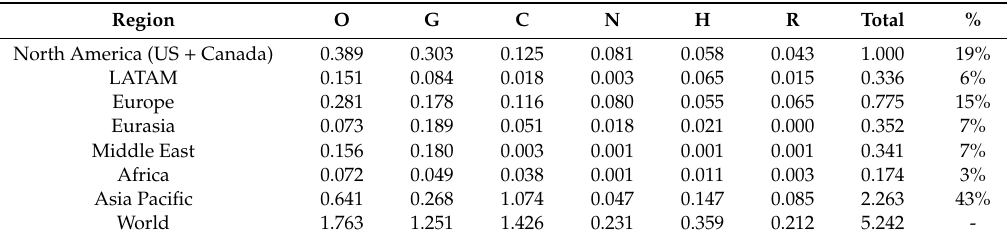
Table 1. World’s relative primary energy consumption by region in 2018. All columns, except the last, are normalised to the North American total (set as 1) (source: World Bank [23]). O = oil, G = natural gas, C = coal, N = nuclear, H = hydroelectricity, R = renewable, % = percent of world total (e.g., Latin America = 0.336 / 5.242 =